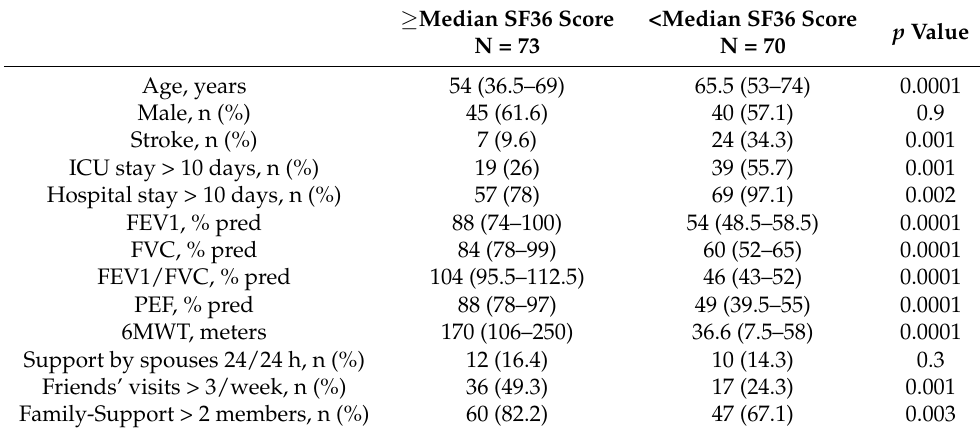
Table 4. Participant characteristics according to the median value of the mental domain of the SF36 questionnaire at 12